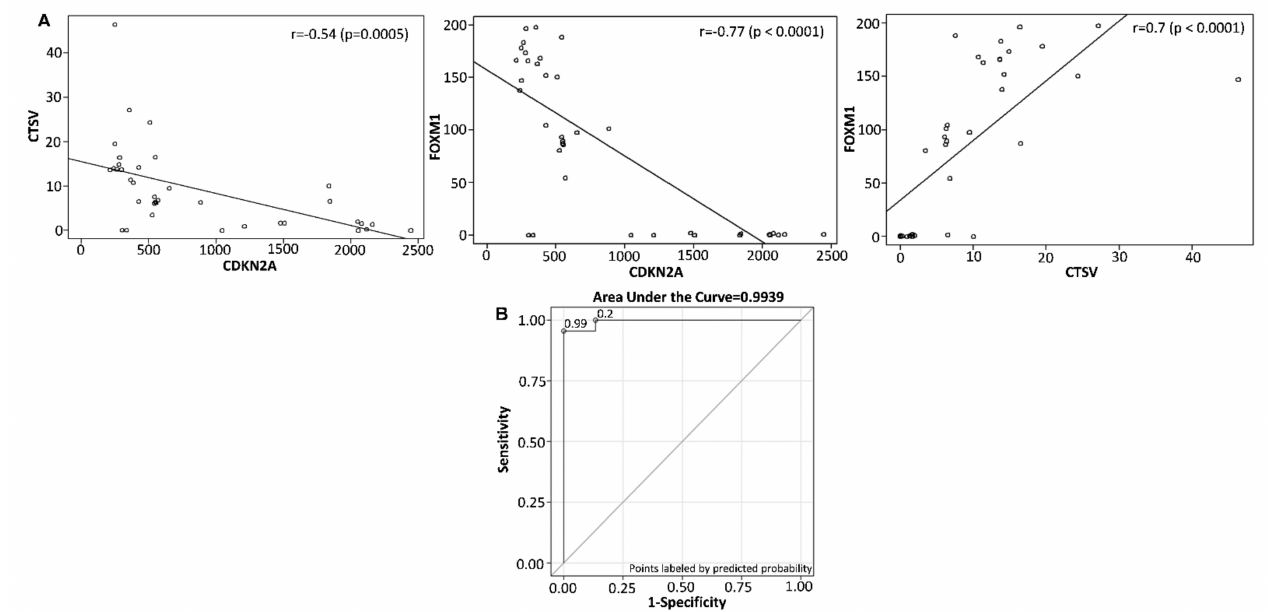
Figure 11. Scatter plot of ( A ) CDKN2A versus CTSV. The Pearson correlation coefficient between CDKN2A and CTSV was − 0.54 ( p = 0.0005). CDKN2A vs. FOXM1. The Pearson correlation coefficient between CDKN2A and FOXM1 was − 0.77 ( p < 0.0001). CTSV versus FOXM1. The Pearson correlation coefficient between CTSV and FOXM1 was 0.7 ( p < 0.0001). ( B ) ROC curve for the combination of three biomarkers (CDKN2a, CTSV, and FOXM1) with AUC = 0.9939, sensitivity of 95.5% and specificity of